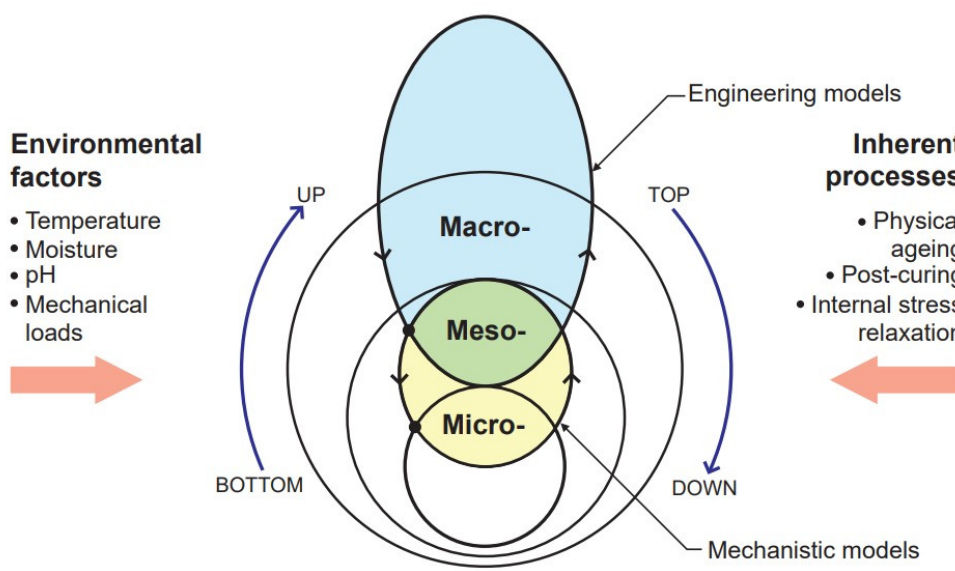
Figure 1. Schematic of models used for prediction of the durability of composite materials).